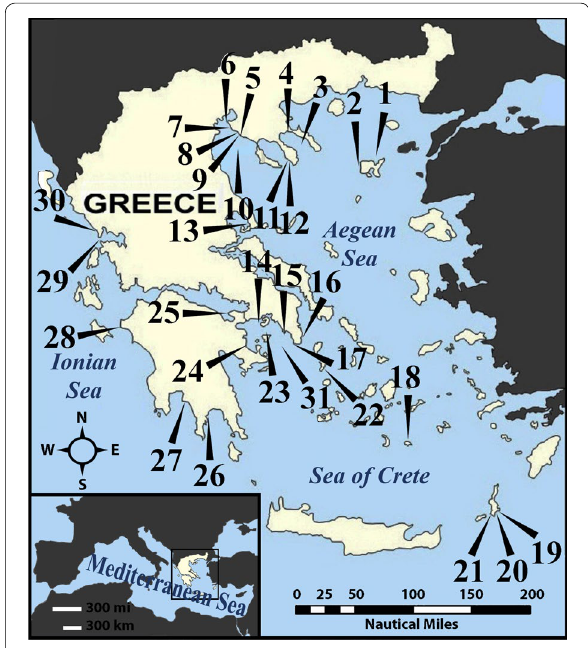
Fig. 1 Map of collection stations for the species reported in this study. Stations in North Aegean Sea: 1. Limnos Island; 2. Kaspakas, Limnos Island; 3. Central Siggitikos Gulf; 4. Pyrgadikia, Chalkidiki; 5. Cape, Epanomi; 6. Aggelohori; 7. Nea Michaniona; 8. Palioura, Epanomi; 9. Paralia, Epanomi; 10. Central Thermaikos Gulf; 11. Toroni, Chalkidiki; 12. Tristinika, Chalkidiki; 13. Chorto, Pagasitikos Gulf. Stations in South Aegean Sea: 14. Eandio, Salamina Island, 15. Anavissos, Attiki; 16. Lavrio, Attiki; 17. Legrena, Attiki; 18. Anafi, Island; 19. Damatria, Karpathos Island; 20. Diakoftis, Karpathos Island; 21. Amoopi, Karpathos Island; 22. Kythnos, Island; 23. Central Saronikos Gulf; 24. Epidaurus Gulf; 25. Ireo, Korynthiakos Gulf. Stations in the Ionian Sea: 26. Gythio, Lakonikos Gulf; 27. Kardamili, Messenian Gulf; 28. Castro, Kyllini; 29. Kanali, Preveza; 30. Pantokratoras, Preveza.